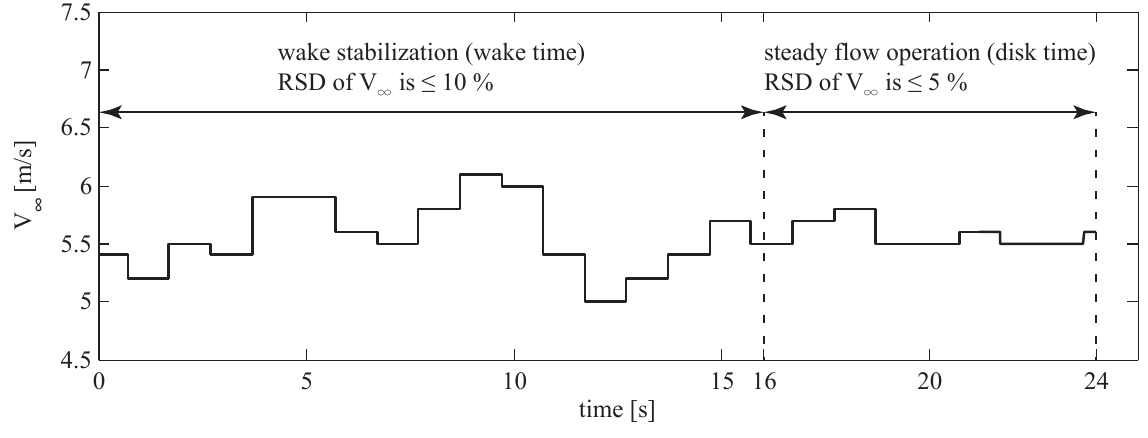
Figure 4. Allowed variations of the asymptotic wind velocity inside a bin with the steady wind flow